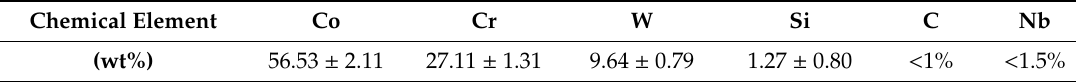
Figure 1. 3D-CAD model of CoCr dental restoration evaluated. Table 1. Chemical composition of CoCr alloy